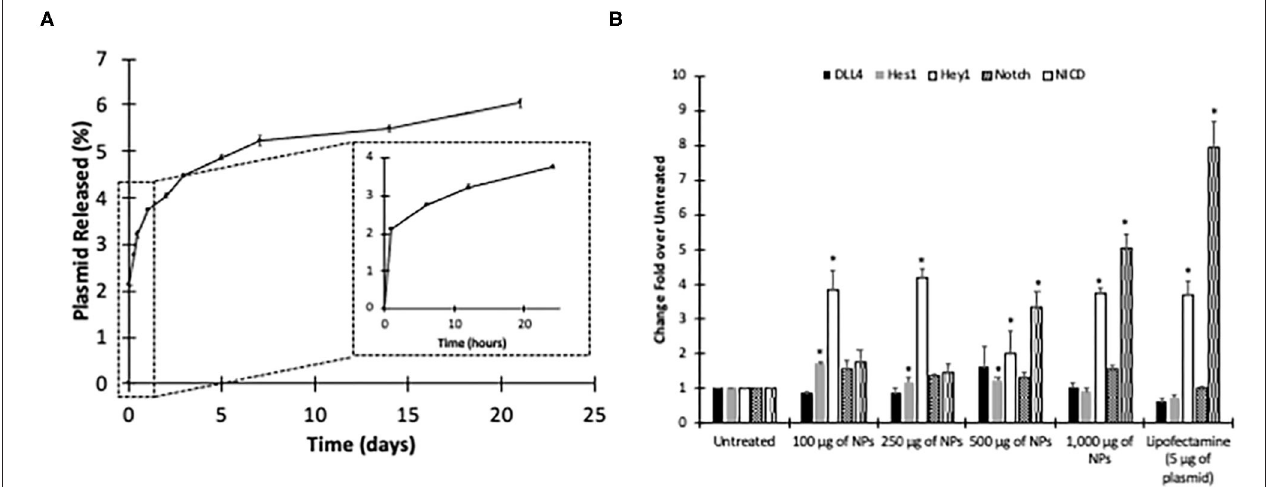
FIGURE 5 | Characterization of NICD Loaded Nanoparticles. Release curve of (A) NICD Plasmid-loaded nanoparticles measured via Promega dsDNA assay after 21 days. n = 3. Data shown as mean ± standard deviation. (B) Quantitative expression of NICD after TetO-FUW-NICD Nanoparticle transfection at varying dosages. *Significantly different from Untreated Group evaluated via two-way ANOVA ( p < 0.05).